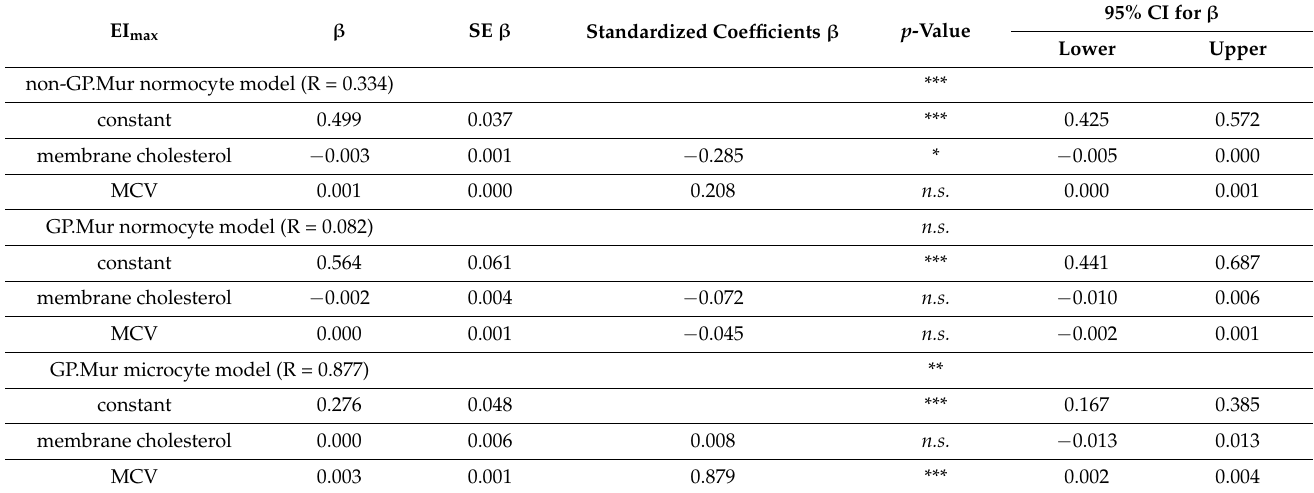
95% CI for β Upper